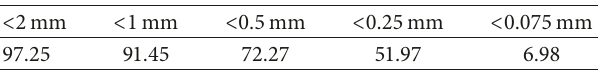
Table 3: Particle-size distribution of the iron tailing sands.